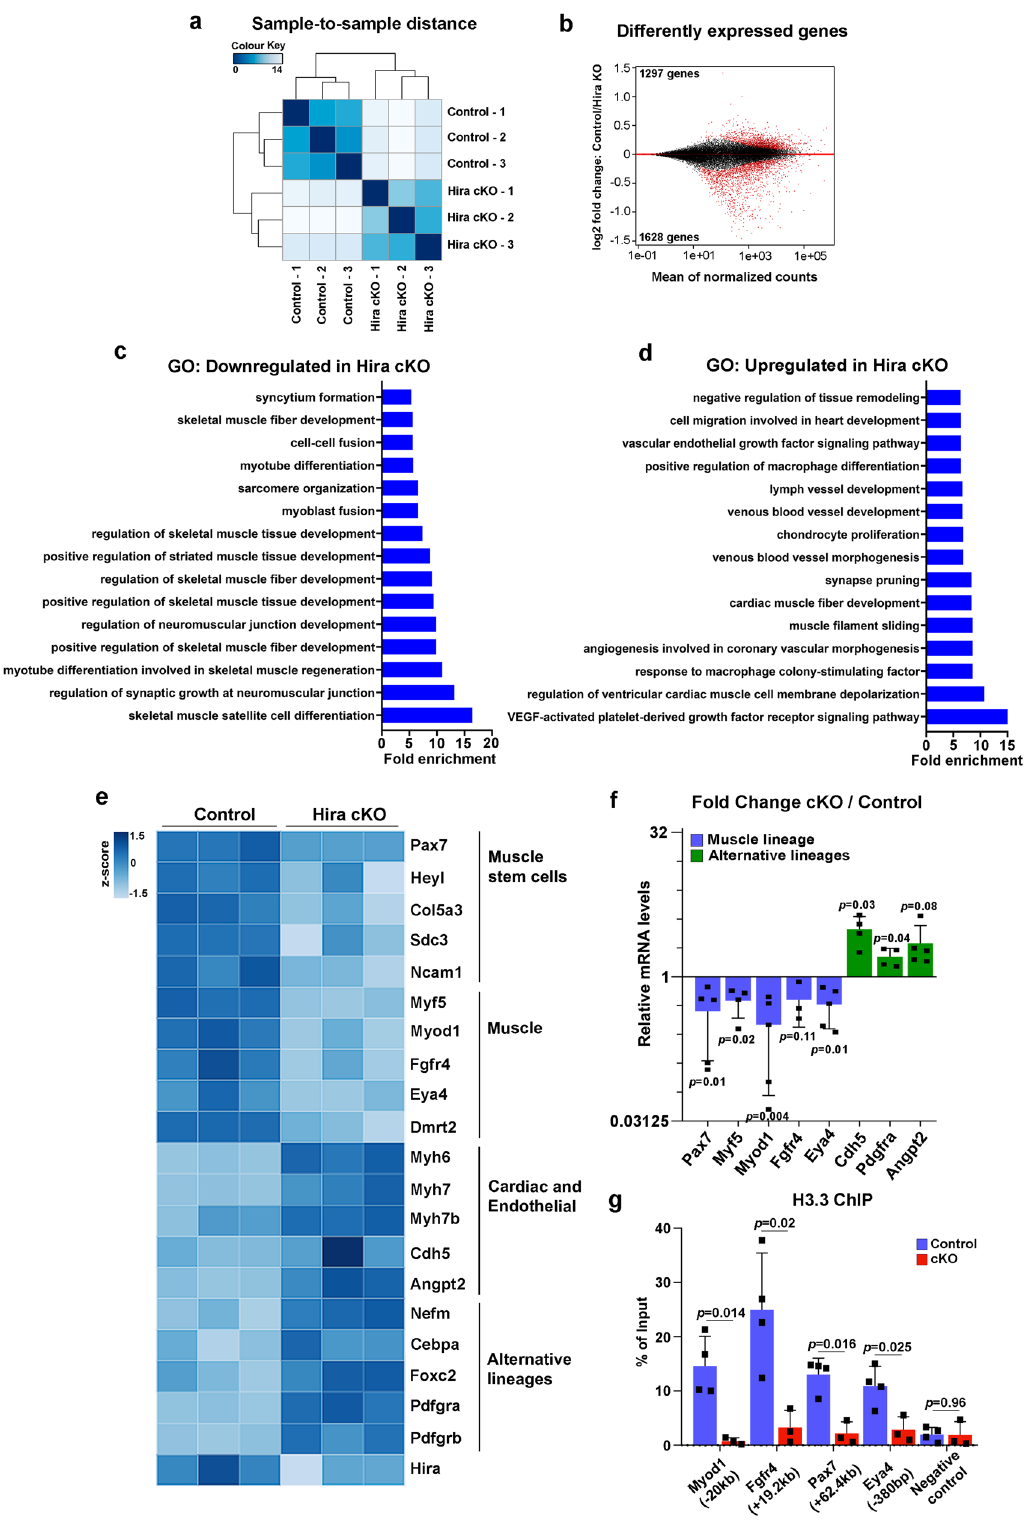
Fig. 4 Hira -de fi cient satellite cells lose myogenic identity. a Differential expression analysis of the RNA-seq analysis performed in 5 dpi satellite cells ( n = 3 independent RNA samples for control and cKO). b MA-plot of control over Hira cKO satellite cells RNA-seq data. Signi fi cantly dysregulated genes are highlighted in red (FDR < 0.05). c , d Gene ontology analysis for biological processes of the downregulated ( c ) and upregulated ( d ) genes in cKO. Selected enriched terms are presented according to the fold enrichment. e Heatmap with the normalized reads per gene of control and Hira cKO RNA-seq data in individual triplicates. f RT-qPCR analyses in satellite cells (5 dpi) from Pax7 CreErt2 ;Hira fl / + and Pax7 CreErt2 ;Hira fl / fl ( n = 5 mice for Pax7, Myod1, Eya4, Angtp2; n = 4 mice for Myf5, Cdh5, Pdgfra; n = 3 mice for Fgfr4). For each gene, the mRNA levels of the control cells were normalized to 1. Error bars, mean ± SD, two-tailed paired t -test. g ChIP-RT-qPCR for H3.3 in Myod1 ( − 20 kb), Fgfr4 ( + 19.2 kb), Pax7 ( + 62.4 kb), Eya4 ( − 380 bp) and the negative control ( − 15 kb Myod1 ) of control (blue, n = 4) and Hira -depleted (red, n = 3) satellite cells (5 dpi). Error bars, mean ± SD, two-tailed unpaired t